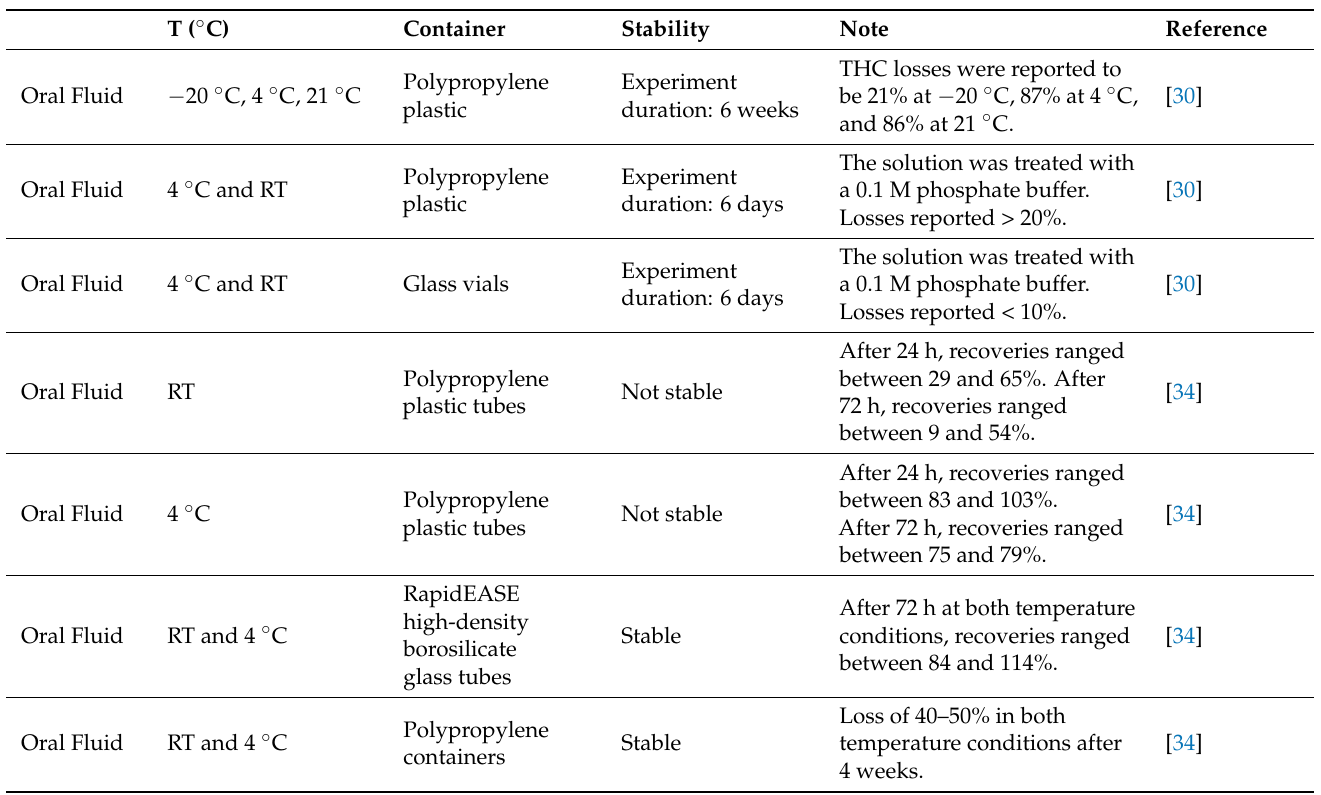
Table 4. Duration of storage stability for cannabinoids in oral fluids based on temperature and collection